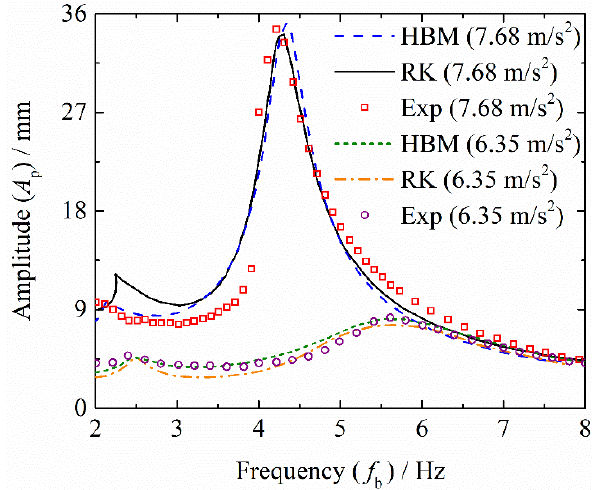
Figure 12. The frequency responses of the damper under the excitation acceleration amplitudes of 6.35 m/s 2 and 7.68 m/s 2 [35]. “HBM”, “RK”, and “Exp” denote the results of the harmonic